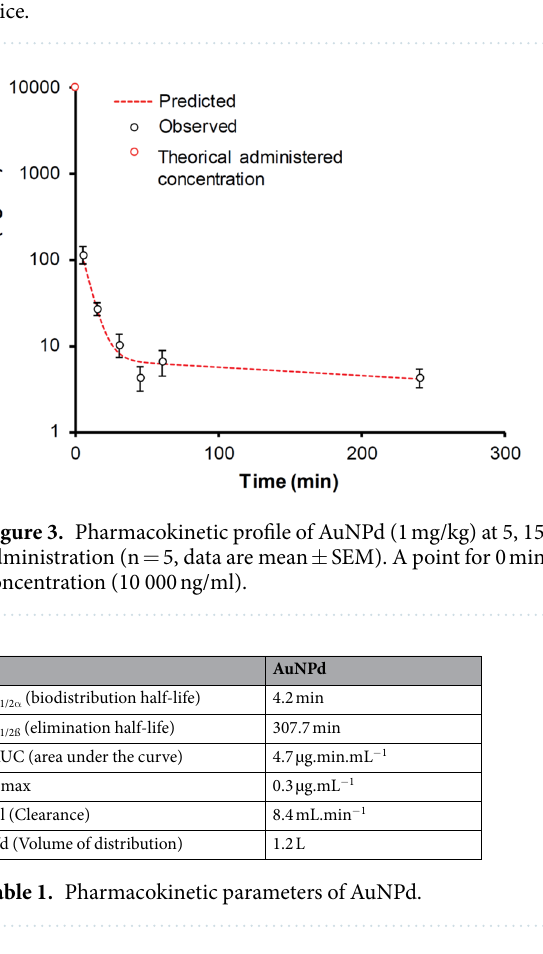
Figure 2. Evolution of the mean body weight of control mice or mice exposed to 1 mg/kg AuNPd. Mice were weighted twice a week throughout the 28 days of the follow-up experiment; data represent the mean ± SEM of 6 mice.